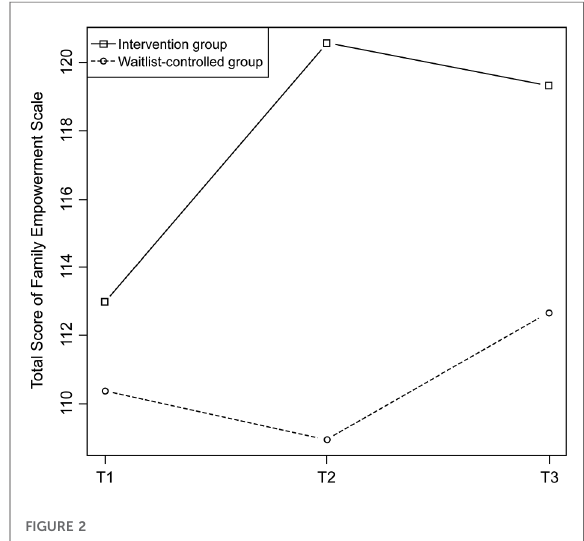
FIGURE 2 Changes in the total score of the family empowerment